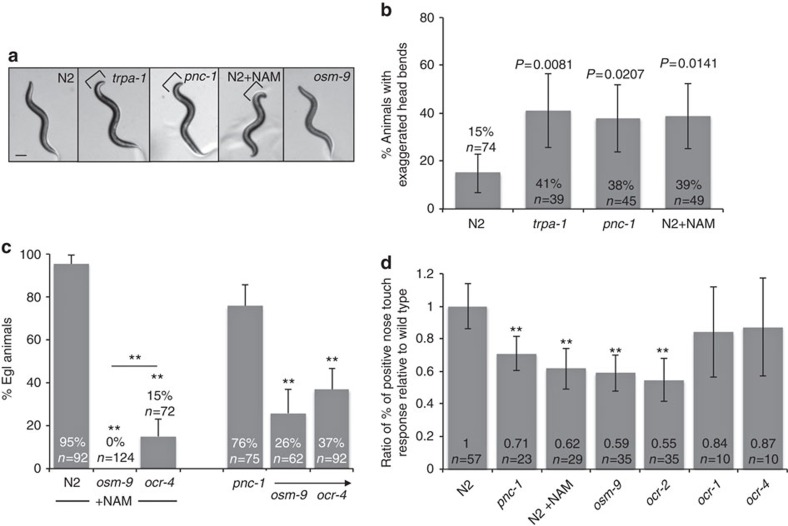
NAM induced behaviours are mediated by osm-9 and ocr-4 expressing cells.(a) Images of L4 animals documenting the foraging, exaggerated nose-bending phenotype (brackets). Scale bar is 100 μm. (b) pnc-1 mutants and NAM supplemented animals have a foraging phenotype consistent with trpa-1 mutants. Error bars are 95% confidence intervals. Actual percentages and number of animals examined is indicated in each bar. P values were calculated using Fisher's exact test with a Bonferroni correction considering three pair-wise comparisons. (c) The NAM-induced Egl phenotype depends on osm-9 and ocr-4 function. Error bars are 95% confidence intervals. Actual percentages and number of animals examined is indicated in each bar. **Bonferroni adjusted P<0.001. (d) pnc-1 mutant and NAM-treated animals have a nose touch defect like that of osm-9 mutants, but ocr-4 mutants do not share this phenotype. We touched each animal ten times, calculated the percentage of touches that resulted in a positive response and reported the ratio of per cent positive responses relative to wild type. The ratio and the number of animals examined for each genotype or condition is indicated on each bar. Error bars are 95% confidence intervals. **Bonferroni adjusted P<0.001.